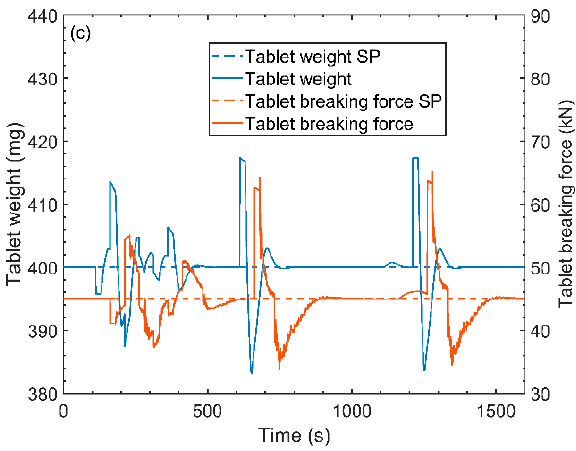
Figure 15. Control strategy 2—Disturbance rejection scenario. ( a ) Critical process parameters ( b ) Actuators ( c ) Critical quality attributes.